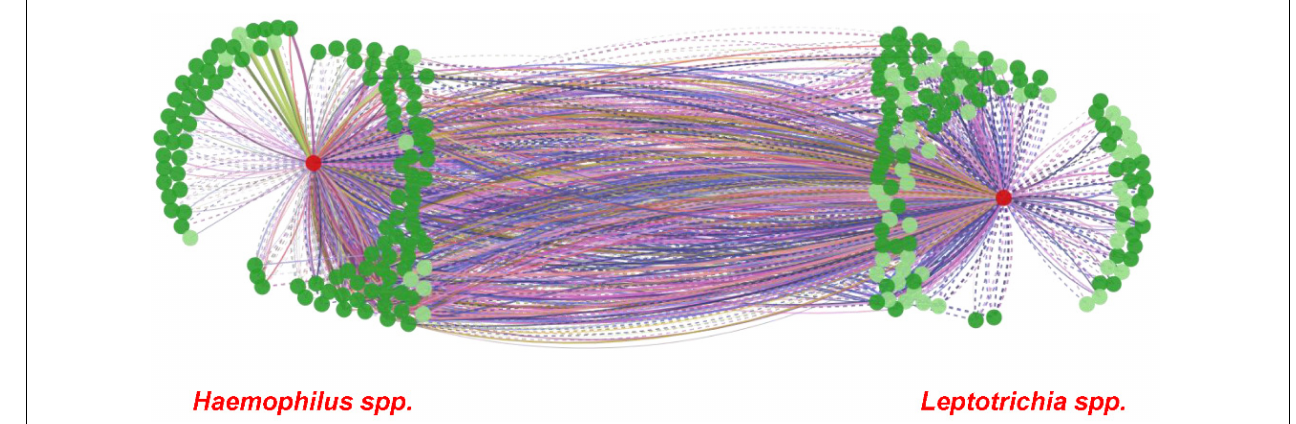
FIGURE 5 | MIND interaction network of Haemophilus and Leptotrichia spp. Microbial Interaction Network Database (MIND; http://www.microbialnet.org/mind_home.html) results, illustrating a network between Haemophilus spp. (left red circle) and Leptotrichia spp. (right red circle) by using MIND default options, are presented. Dark green circles depict genera that interact with Haemophilus spp./ Leptotrichia spp., and light green circles depict species that interact with Haemophilus spp./ Leptotrichia spp. The lines between Haemophilus spp. and Leptotrichia spp. show interactions in common with other genera and species. The different color lines depict the human tissue sites where interactions have been demonstrated in previous studies (MIND;